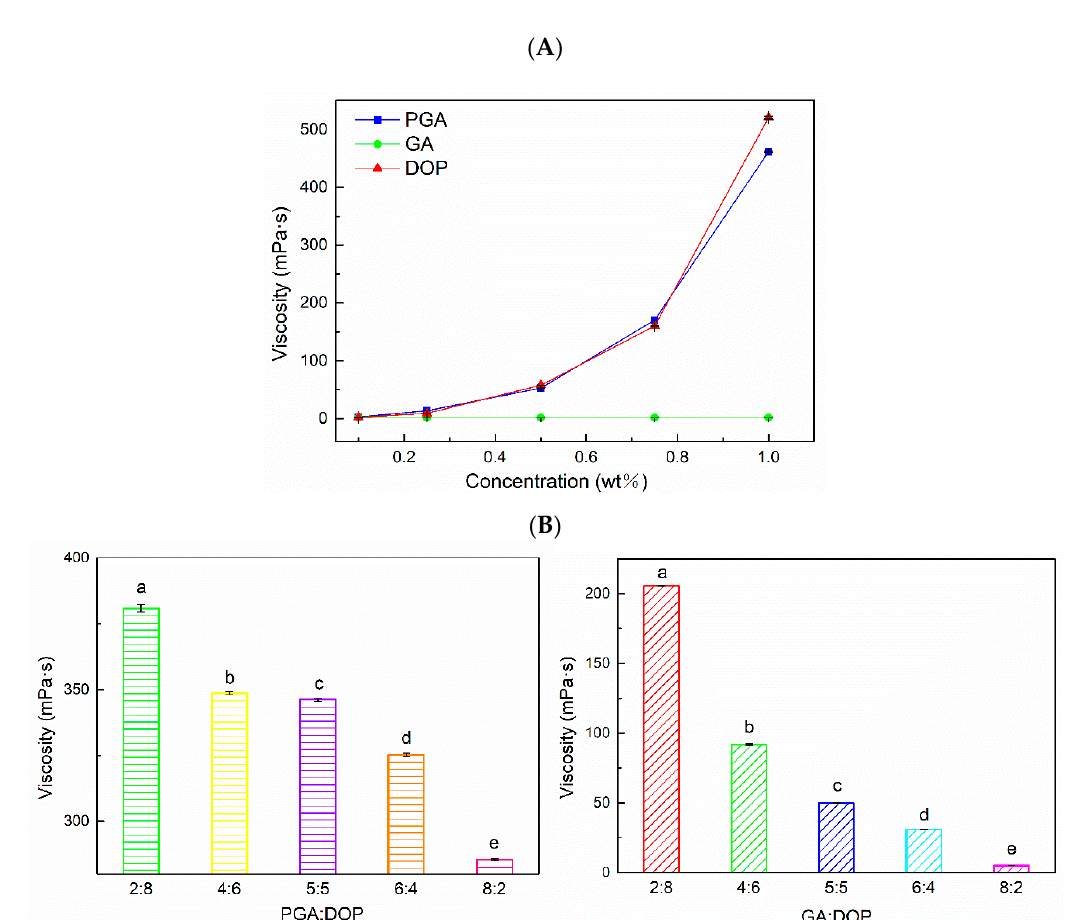
Figure 1. ( A ) Relationship between apparent viscosity and concentration of three polysaccharides. ( B ) Apparent viscosity of the compound polysaccharides at different ratios (total concentration was 1 wt%); a–e indicate significant differences ( p < 0.01).